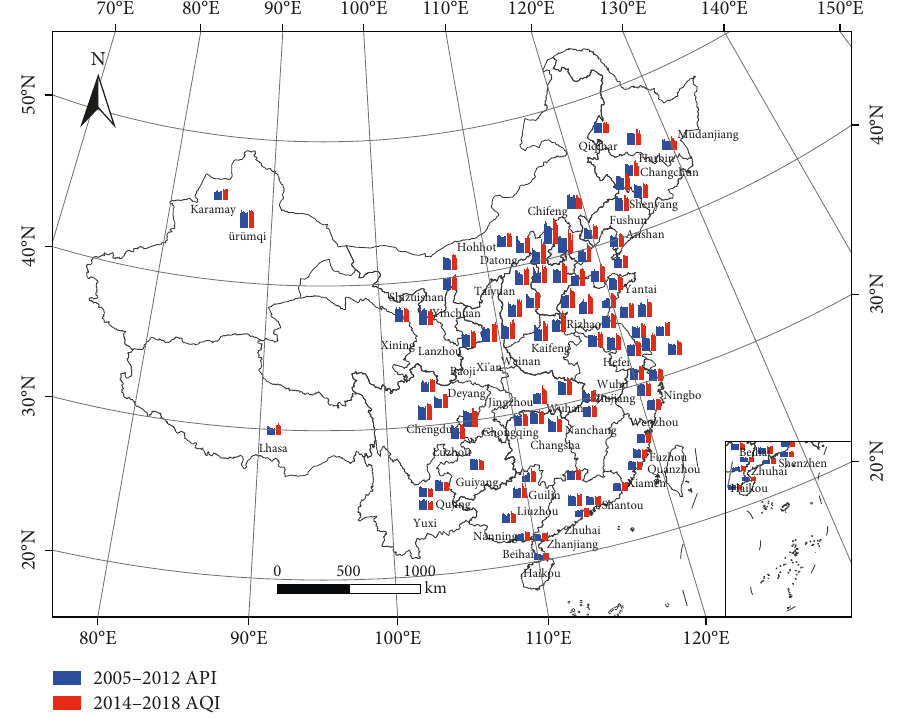
Figure 5: Interannual changes of the API and